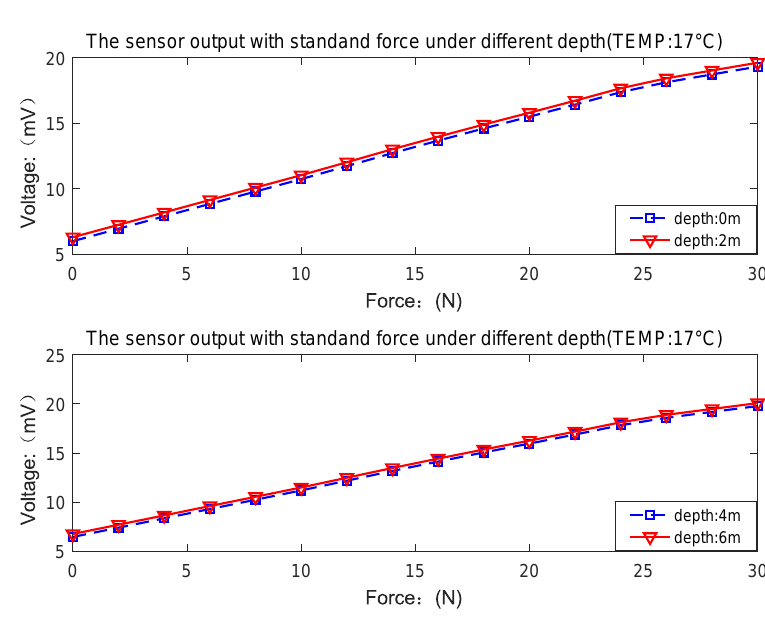
Figure 17. Photo: the pool experiment of UTFS.